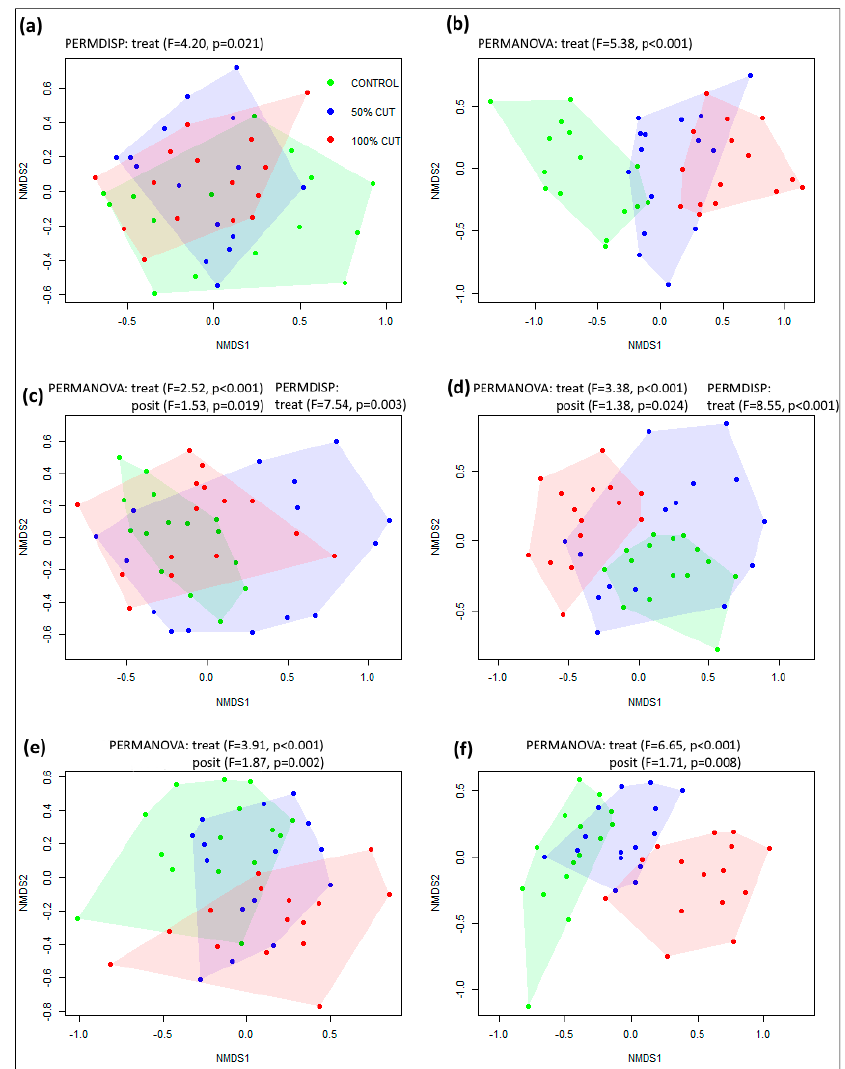
Figure 3. Non-metric multidimensional scaling (NMDS) ordination diagrams of the pre-treatment understory communities (panels ( a , c , e )) and post-treatment understory communities (panels ( b , d , f )), separately for each study location: Trnovo ( a , b ), Snežnik ( c , d ), and Koˇcevski Rog ( e , f ). Convex hulls enclose different management intensities (control, 50% cut, 100% cut). Significant results from PERMANOVA and PERMDISP analysis are reported (treat = treatment, posit = within-sinkhole position).